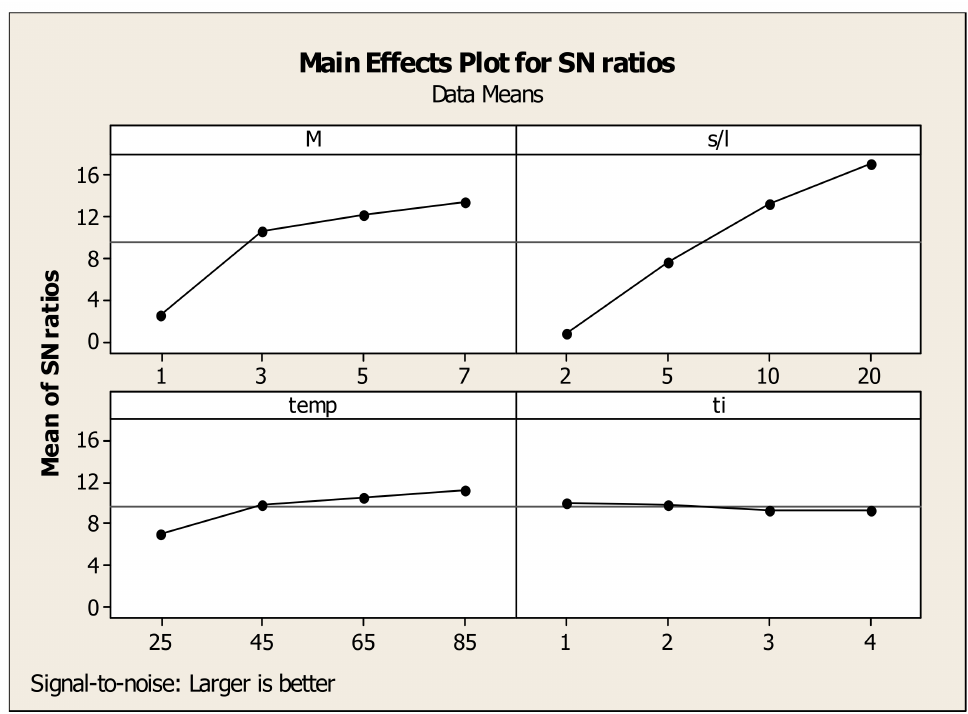
Figure 12. Effects of each factor associated with their levels on the statistical performance of S/N ratio for Sc concentration.